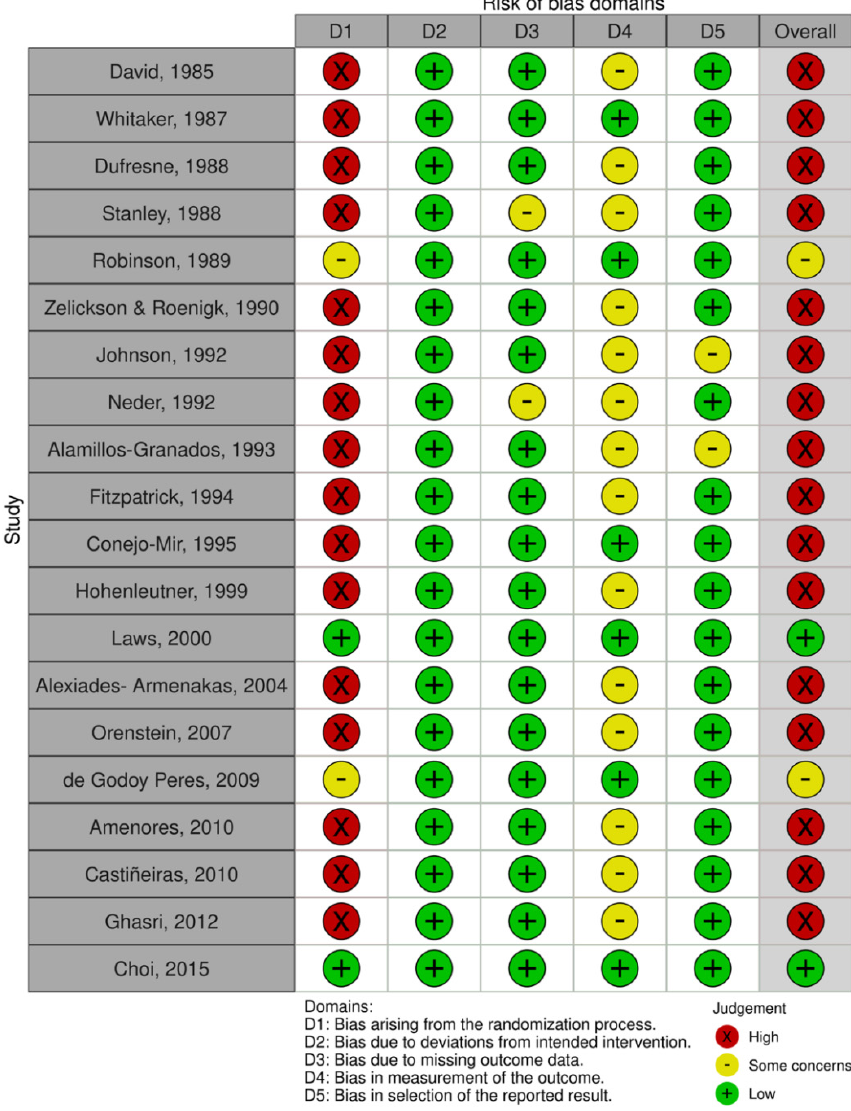
Figure 4. Quality plot graphically depicting the critical appraisal categorized in bias domains, across primary-level studies, using the Cochrane Collaboration’s tool for assessing risk of bias (RoB-2 tool). Green, low risk of potential bias; yellow, some concerns; red, high risk of potential bias.